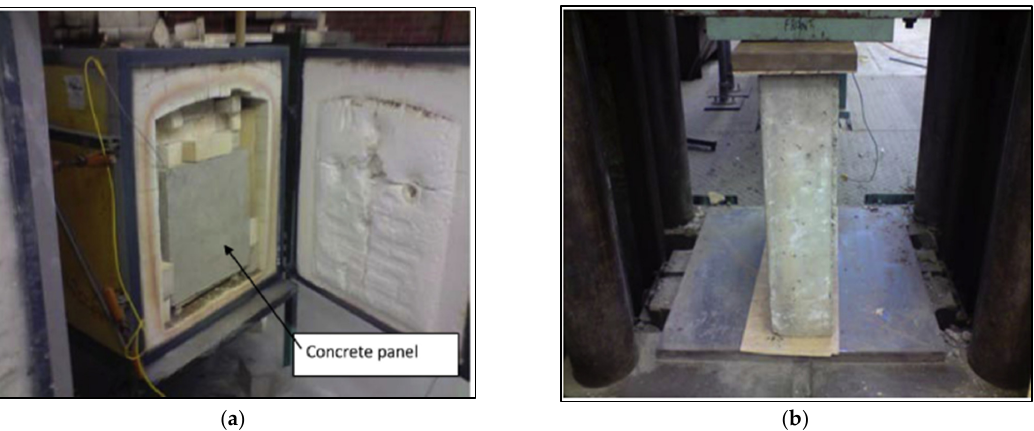
Figure 14. Fire ‐ resistance testing on steel ‐ reinforced fly ‐ ash geopolymer concrete: ( a ) concrete test Figure 14. Fire-resistance testing on steel-reinforced fly-ash geopolymer concrete: ( a ) concrete test panel and ( b ) post ‐ fire compression test setup. panel and ( b ) post-fire compression test setup.